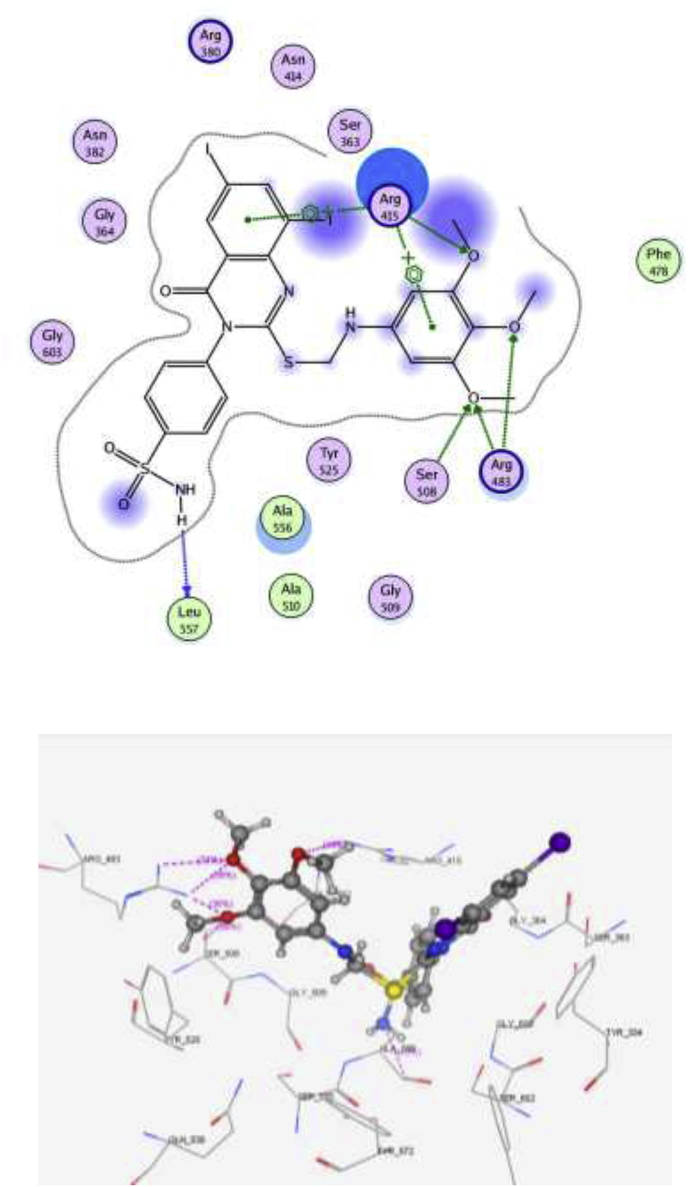
2D and 3D interaction pose of compound 15 showing cation-π, π-π interactions inside the binding pocket of 4IQK.